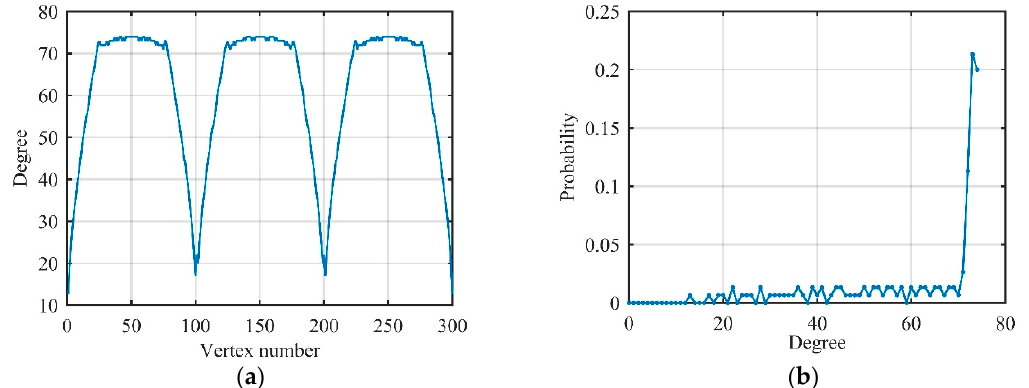
Figure 6. Related degree features of the sinusoidal signal on visibility graphs. ( a ) Degree of each vertex; ( b ) degree distribution.